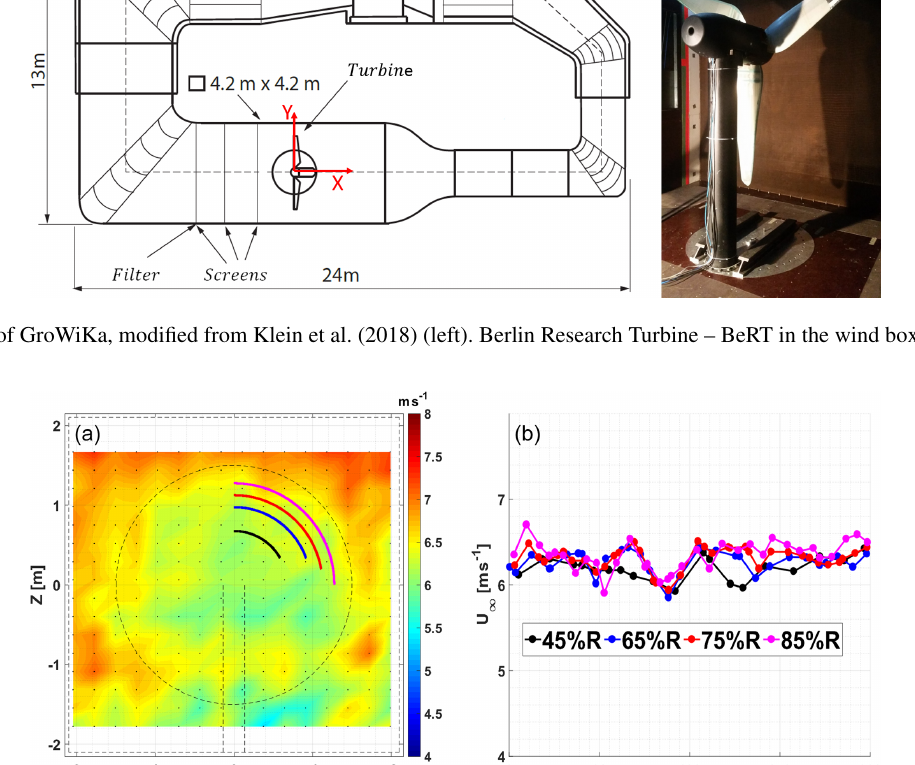
wind turbines, results in the velocity ratio of U ∞ /U (cid:48) = 0 .